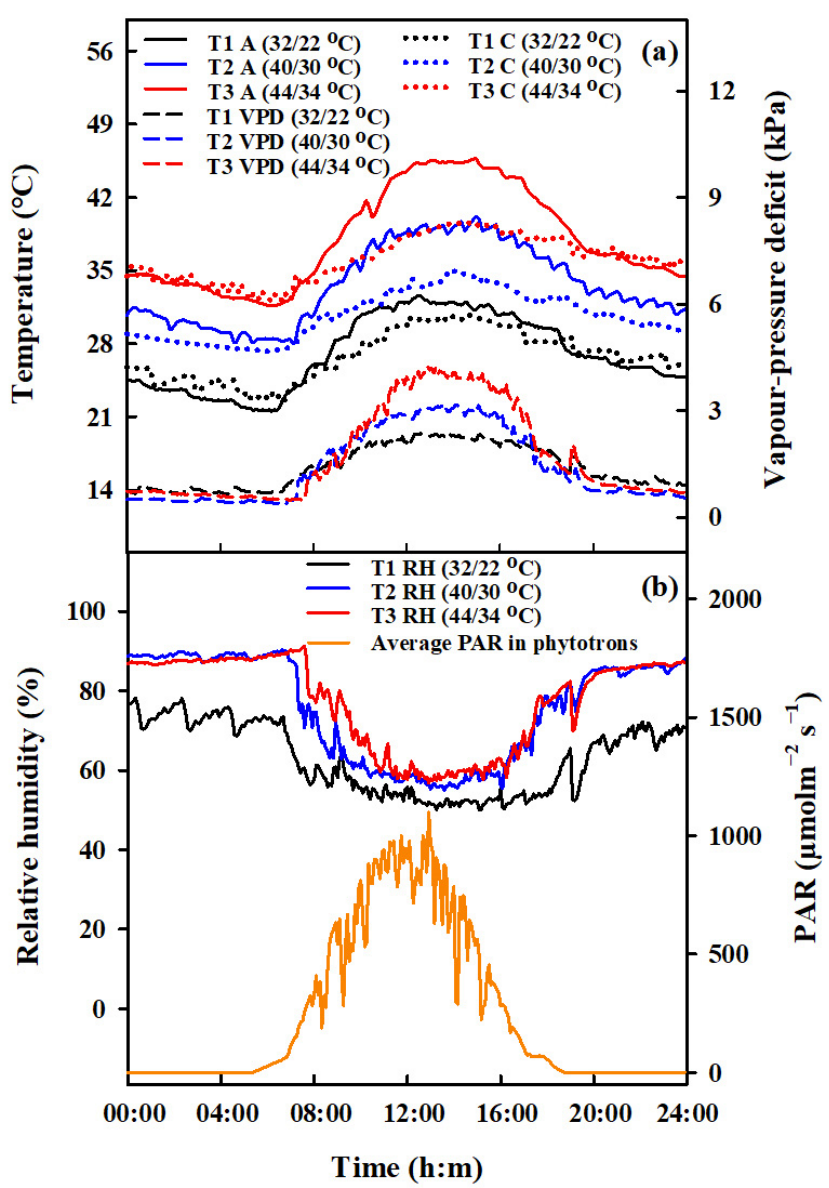
Figure 1. Design of the daily dynamics of temperature, vapor pressure deficit, relative air humidity and photosynthetically active radiation in the environment-controlled phytotron. Diurnal variations of air (A, °C, solid lines, ( a ) left vertical axis), and canopy temperature (C, °C, dotted lines, ( a ) left vertical axis), vapor pressure deficit (VPD, kPa, dashed lines, ( a ) right vertical axis), relative air humidity (RH, %, solid lines, ( b ) left vertical axis), and average photosynthetically active radiation (PAR, μ molm − 2 s − 1 , ( b ) right vertical axis) in phytotrons during heat stress treatments in 2016. To examine the grain yield per plant (YPP, g per plant), panicle number per plant (PNPP), spikelet number per panicle (SNPP), spikelet fertility (SF, %), and 1000 ‐ grain